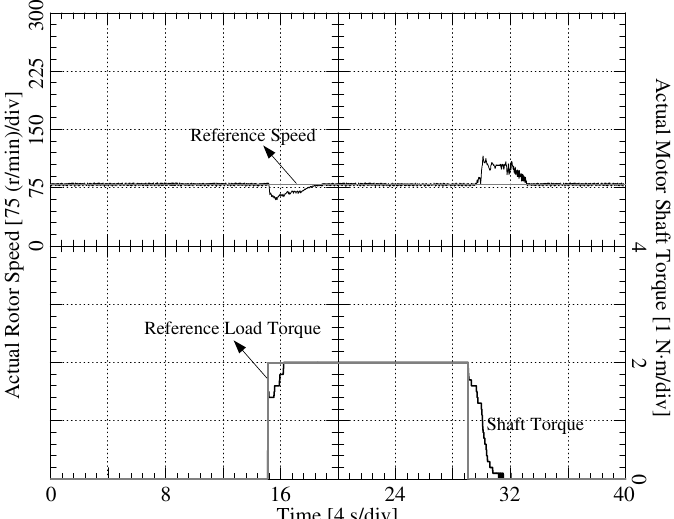
Figure 14. Experimental transient speed test (120 r/min to 90 r/min) under full load (2 N·m) with K = 5 (high) while R s is increased by 82.35% and λ f is decreased by 40%.